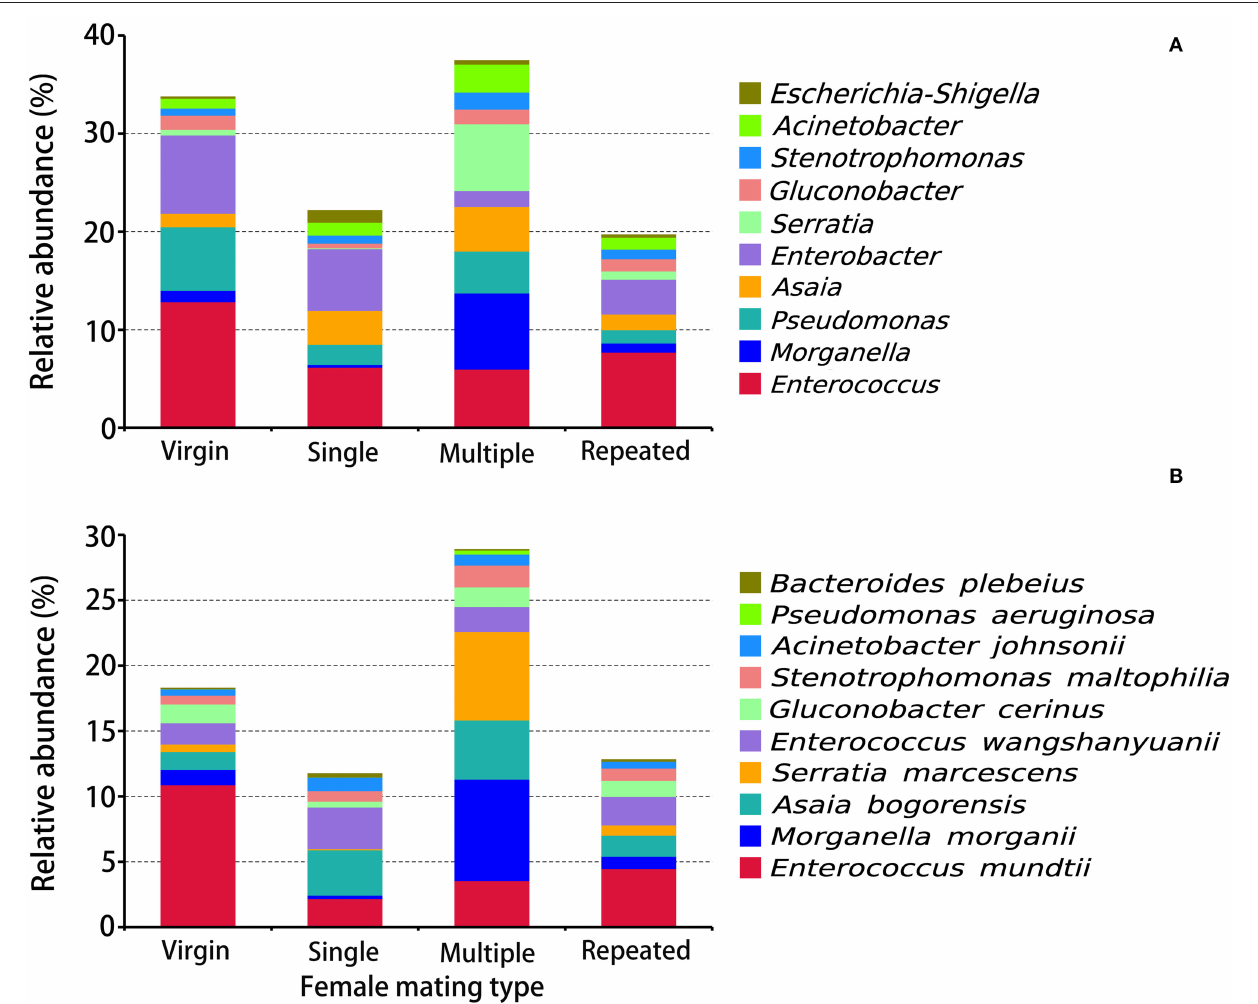
FIGURE 4 | Taxonomy assignment of bacterial OTUs at the genus and species levels in S. frugiperda females of different mating types. (A) The abundance pattern at the genus level (top 10). (B) The abundance pattern at the species level (top